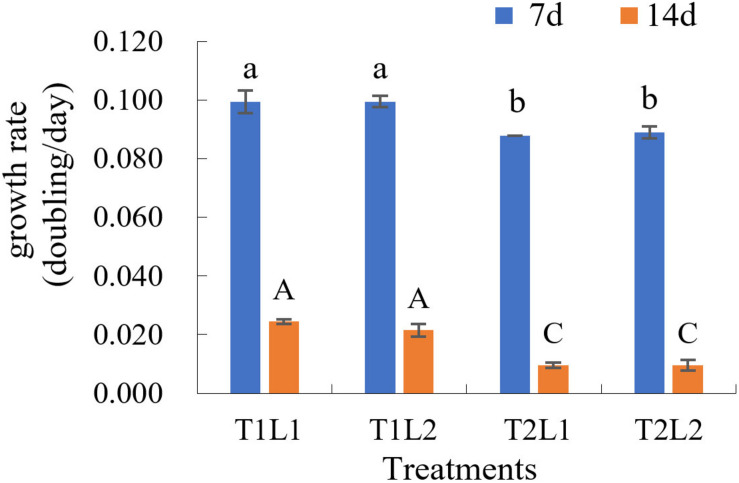
The growth rate (K, doubling/day) of GF19C1 in the orthogonal experiments of illumination (weak L1/strong L2) and temperature (low T1/high T2). Each set of treatments has three replicates (n = 3). The error bars stand for standard deviation (SD). Superscripts in lowercase and uppercase letters denote twice ANOVA multiple comparisons, followed by Tukey post hoc to locate the significant differences. Different letters within the same comparison group mean significant difference (ANOVA, P < 0.05).